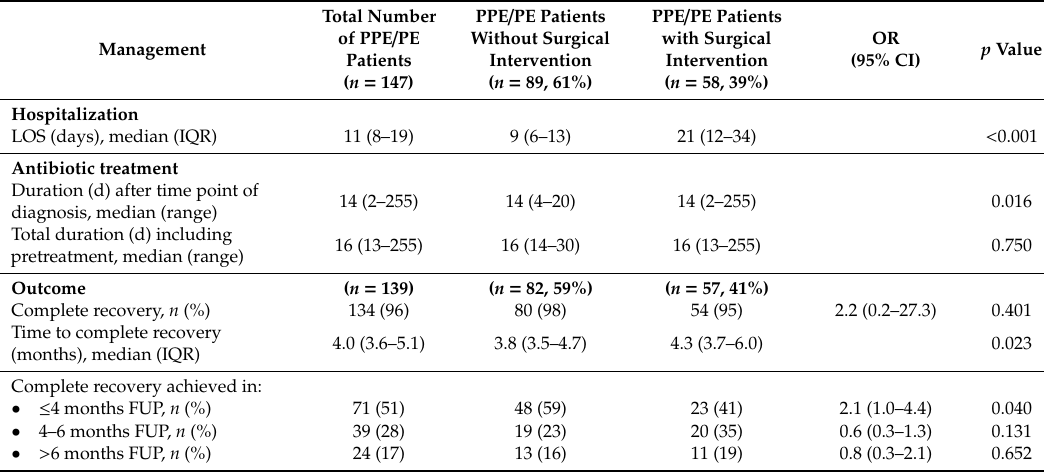
(Table 1). The median LOS of all 147 children with PPE / PE was 11 days (IQR 8–19 days). PPE / PE patients with surgical interventions were significantly longer hospitalized than those with pleural tap alone (LOS 21 vs. 9 days, p < 0.001; Table 3). Table 3. Management and outcome of the 147 children with PPE /